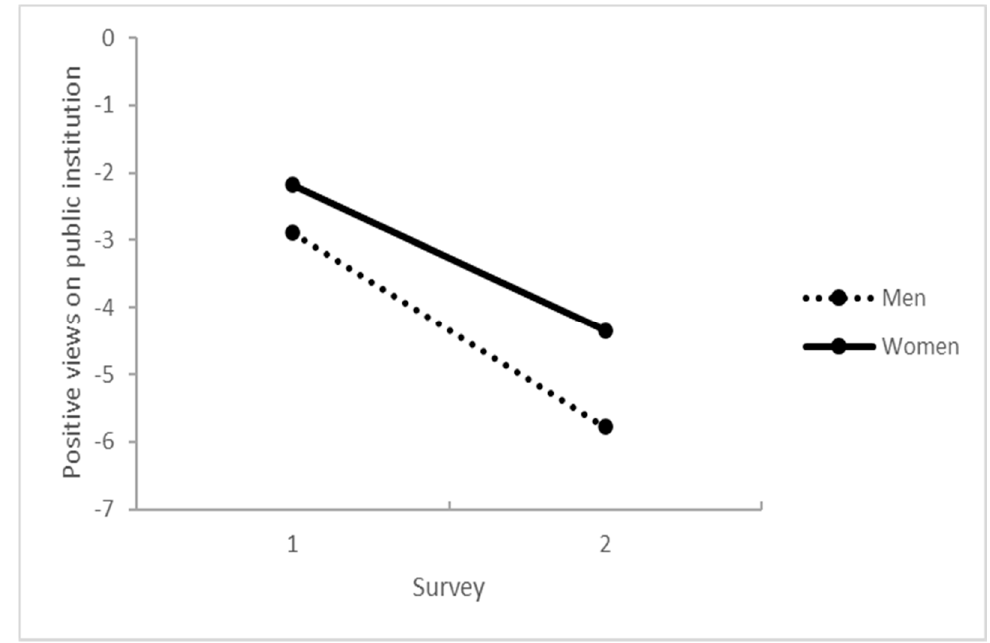
Figure 3. Interactions between the number of surveys and sex predicting positive views on communication and activities of public institutions.